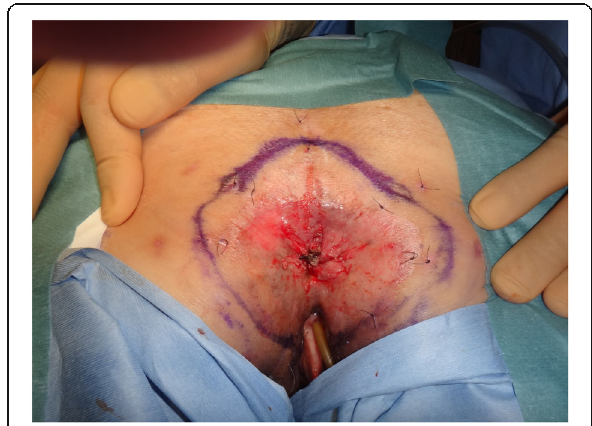
Fig. 1 Macroscopic view of the perianal skin. A 60×75-mm pagetoid spreading lesion is visible around the anus